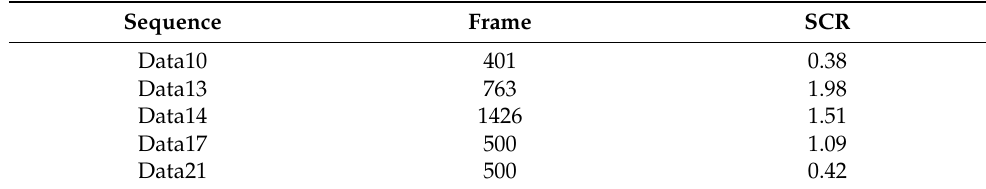
Table 6. Low SCR sequence.